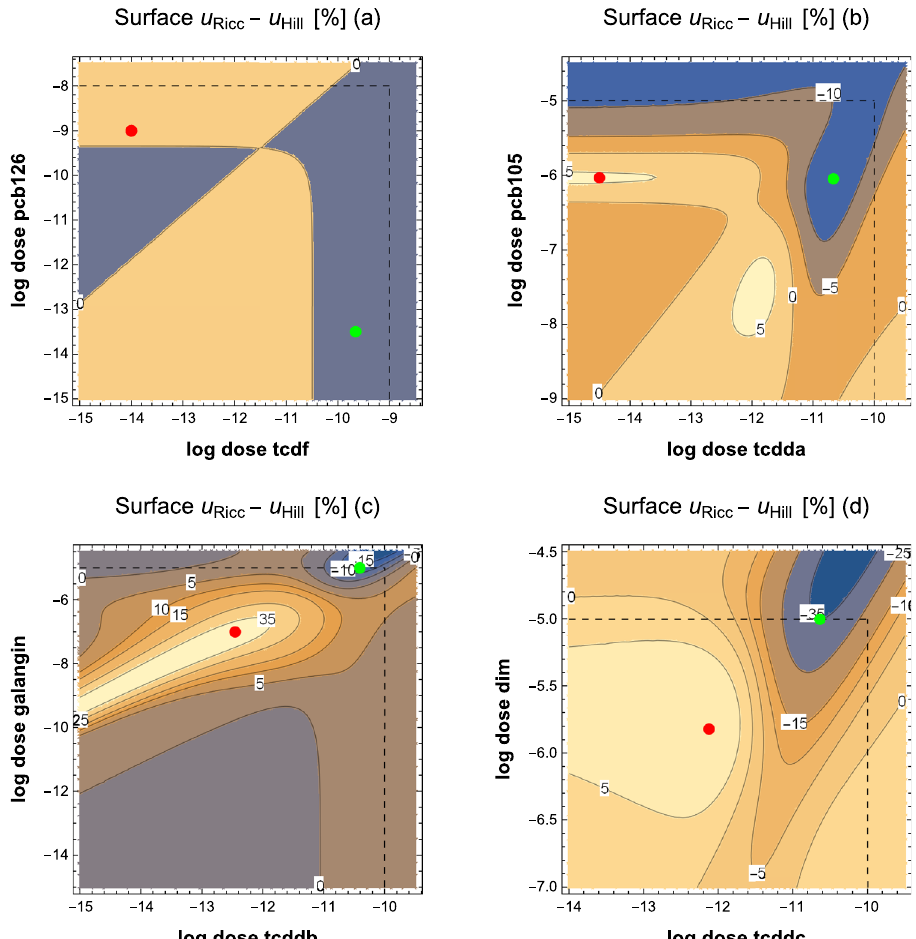
Figure 4. Synergy surfaces of binary AhR ligand mixtures (in %) , obtained as u Ricc − u Hill using the respective optimum parameter set from Table 4, according to the AIC criterion. Dashed lines denote maximum doses used in the experiments. The observed responses range from null-interaction within exptl. error ( a ) TCDF+PCB126 (parameter set 1”) and ( b ) TCDD+PCB105 (parameter set 5) to simultaneous presence of synergism and antagonism ( c ) TCDD+Galangin (parameter set 3) and clear antagonism ( d ) TCDD+DIM (parameter set 4). Green an red dots refer to minima and maxima of the synergy